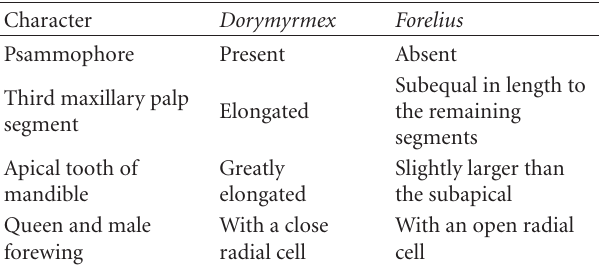
Table 1: Major characters di ff ering among worker, queen, and male of Dorymyrmex and